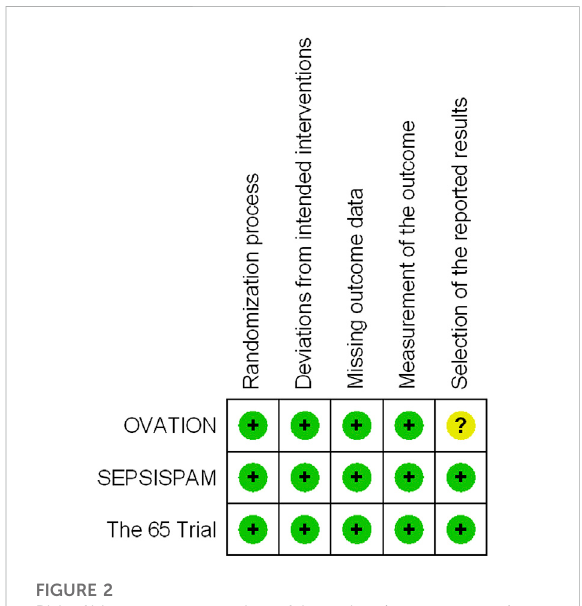
FIGURE 2 Risk of bias summary: a review of the authors ’ assessments of each risk-of-bias item for each included